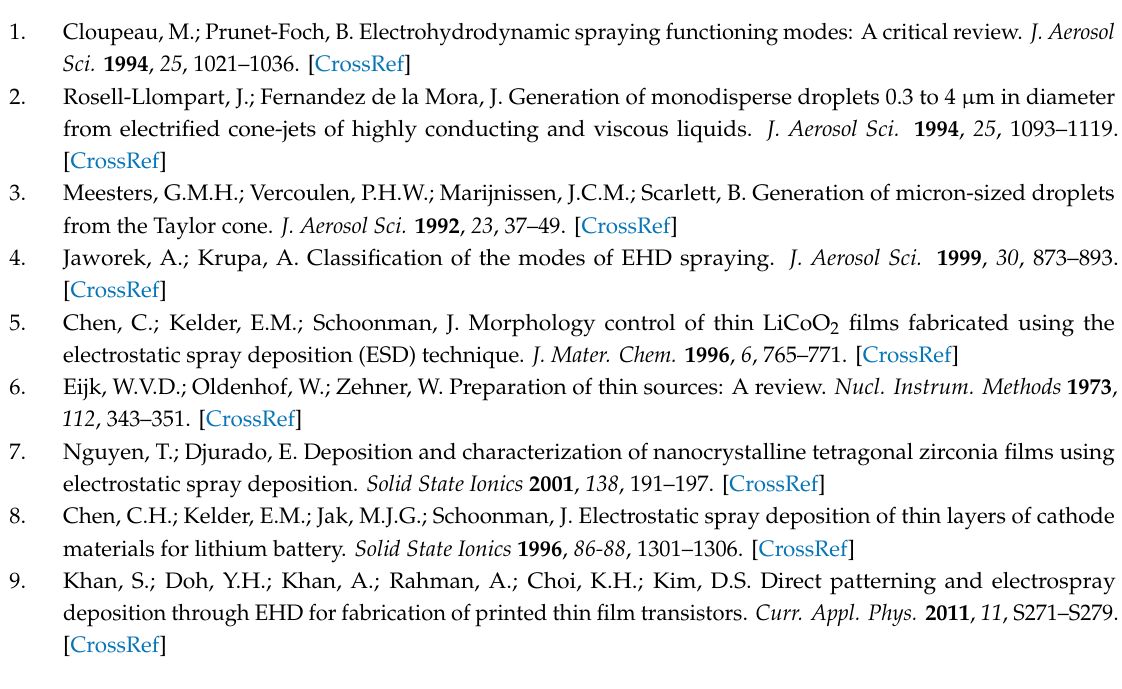
Figure S1. Measured droplet size of air-spray jets without applying external electric field, Figure S2. Measured droplet size of air-spray jets with applying external electric field of 15